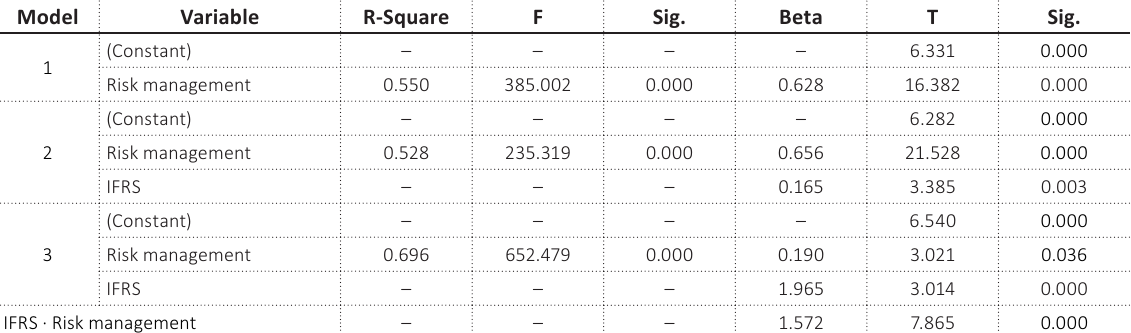
Table 4. Moderating